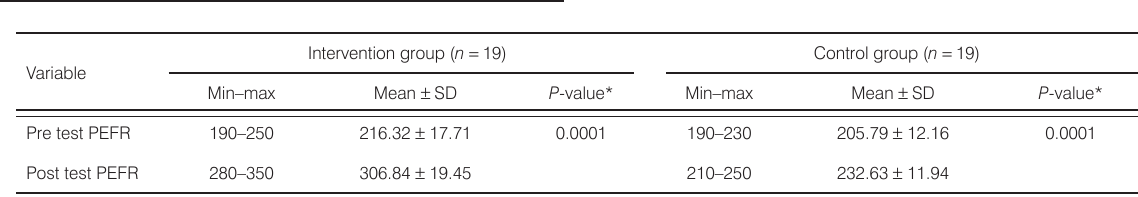
Table 2. Effect of the combination of diaphragmatic breathing exercise with therapeutic walking exercise on PEFR ( N = 38).